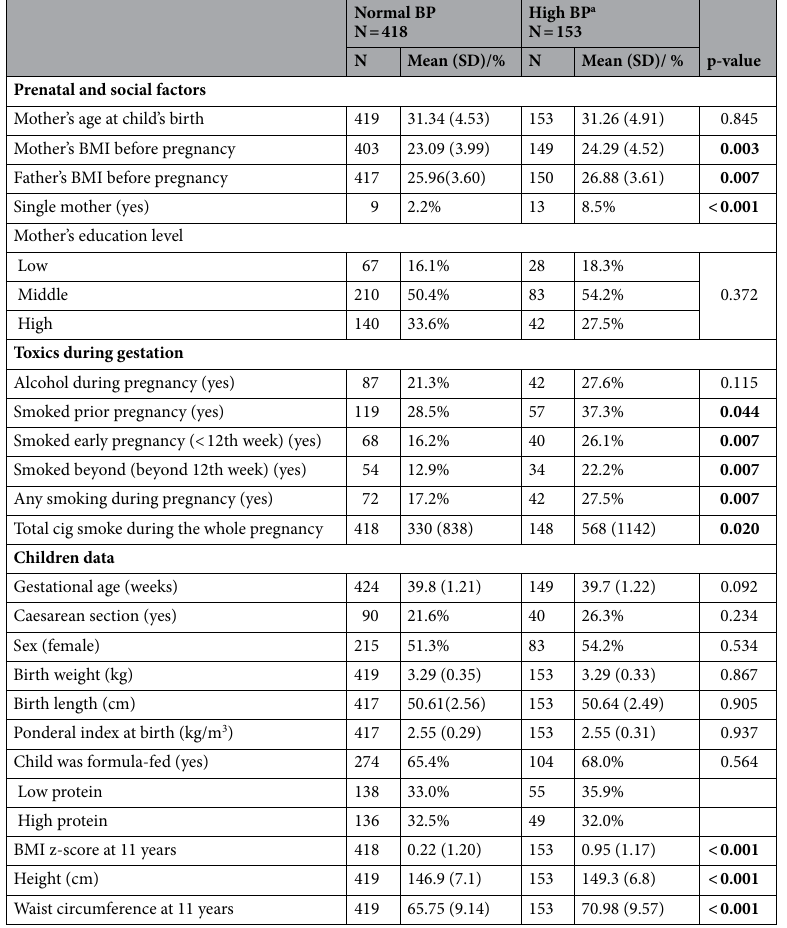
Table 2. Mother and child characteristics according to children blood pressure status at 11 years. Significant values are in bold. a High blood pressure defined as ≥ 90th percentile or ≥ 120/80 mmHg whatever is lower according AAP guidelines.